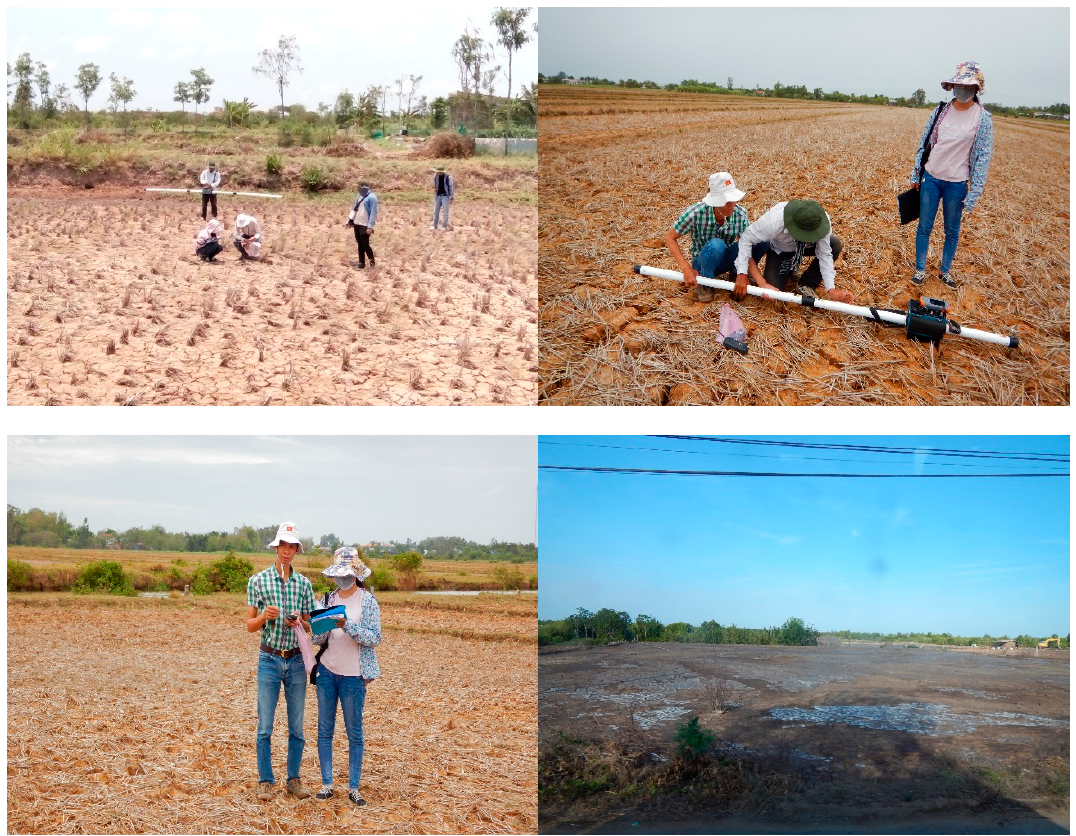
Figure 2. Photo of two sample site at the Ben Tre province (the photos were taken on April 2018 by Figure 2. Photo of four sample sites at the Ben Tre province (these photos were taken on April 2018 by Pham Viet Hoa). Pham Viet